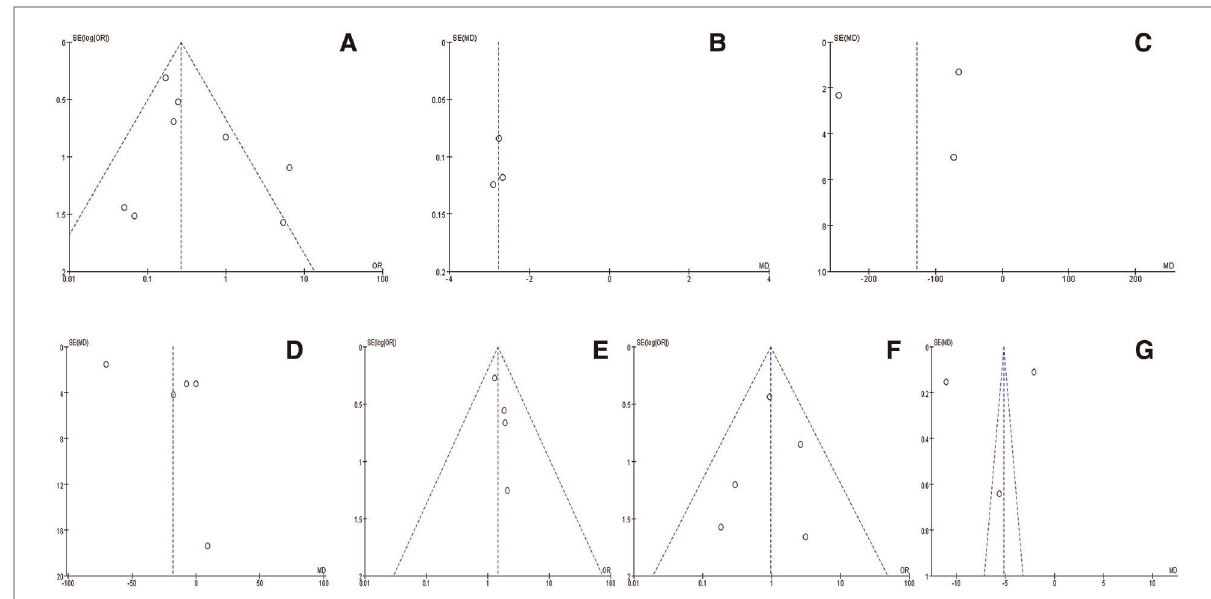
FIGURE 4 Funnel charts for publication bias. ( A ) Complication rates; ( B ) Length of incision; ( C ) Amount of intraoperative blood loss; ( D ) Length of operation; ( E ) Excellent rates; ( F ) Reoperation rates; ( G ) Length of hospital